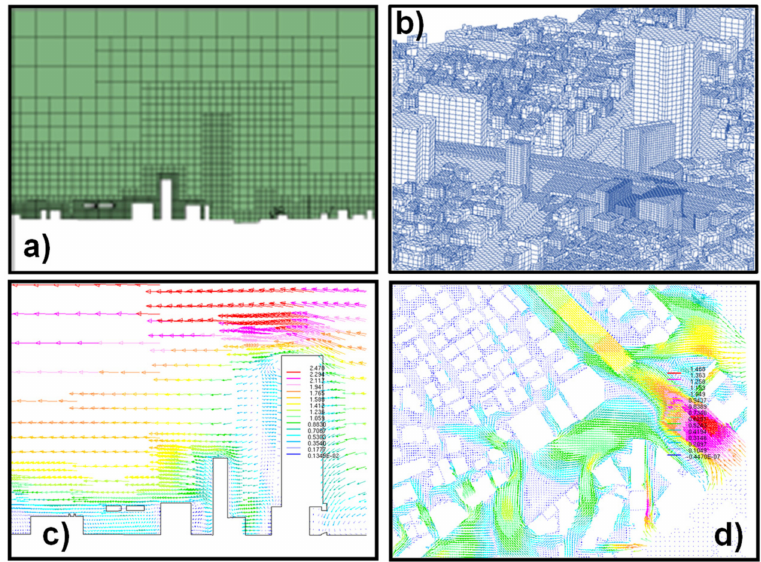
Figure 19. Roadside Air Quality Model structure and wind flow. ( a ) Cross section of calculation mesh. Fine mesh for central area and coarse mesh for surroundings. ( b ) Bird’s-eye view of calculation mesh. ( c ) Calculated wind velocity field for cross section. ( d ) Calculated wind velocity field section approx. 2 m above the